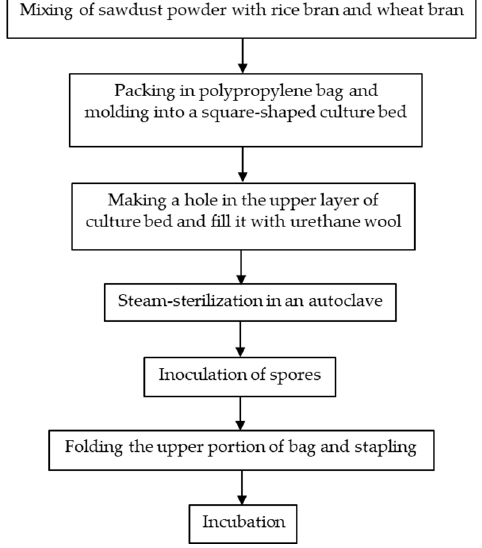
Figure 1. A typical bag culture procedure for the G. frondosa fruiting body.